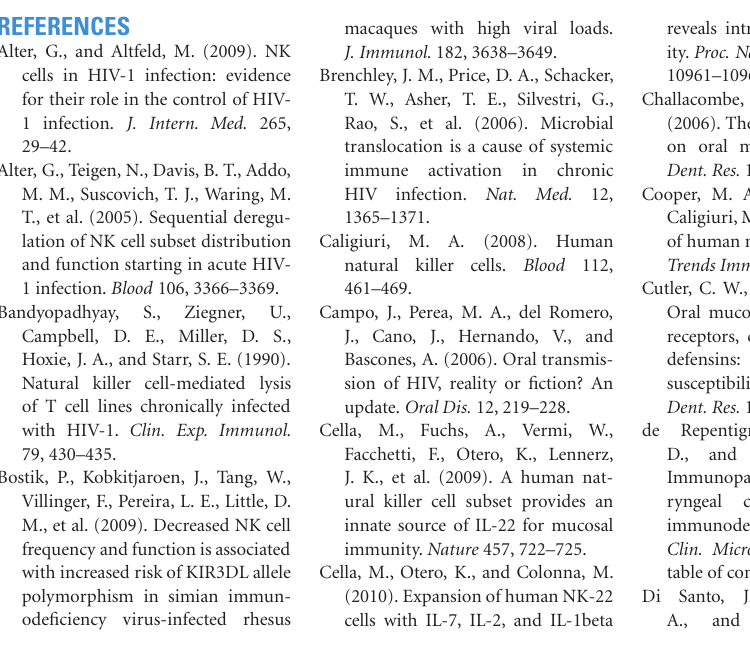
FIGURE 5 | Chronic SIV infection alters functional profiles of oral mucosal NK cells and ILCs. (A) Intracellular perforin expression was determined in NK cells and ILCs ex vivo ; bars represent means ± SEM for 6–8 animals per group. (B) OLN mononuclear cells were stimulated with PMA/ionomycin for 12h and then CD107a expression, and IL-17, TNF- α , IFN- γ , and MIP-1 β production were measured in NK cells and ILCs in naïve and SIV-infected macaques. The monofunctional profiles of each